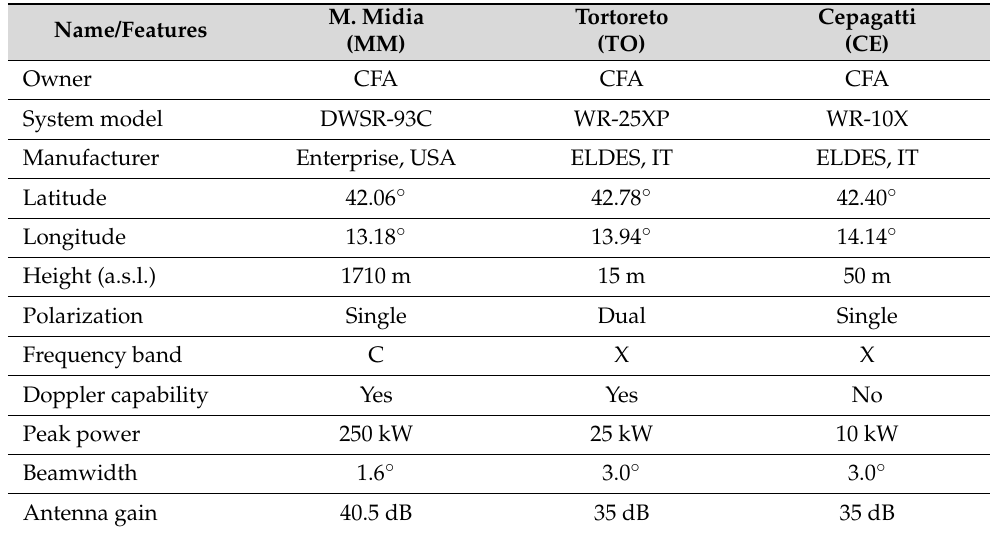
Table 1. Technical specifications of the three weather radars, installed in the Abruzzo